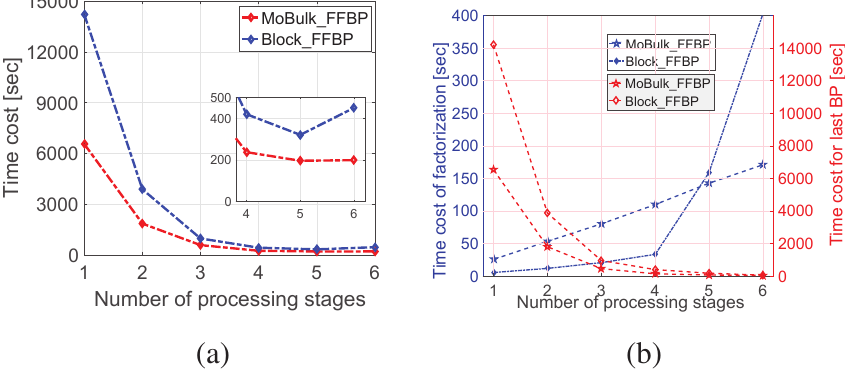
Figure 10. Comparative analysis of the execution times of Block_FBP and MoBulk_FBP. ( a ) The total processing time when K = { 1,2,3,4,5,6 } . ( b ) Time costs of the factorization and residual